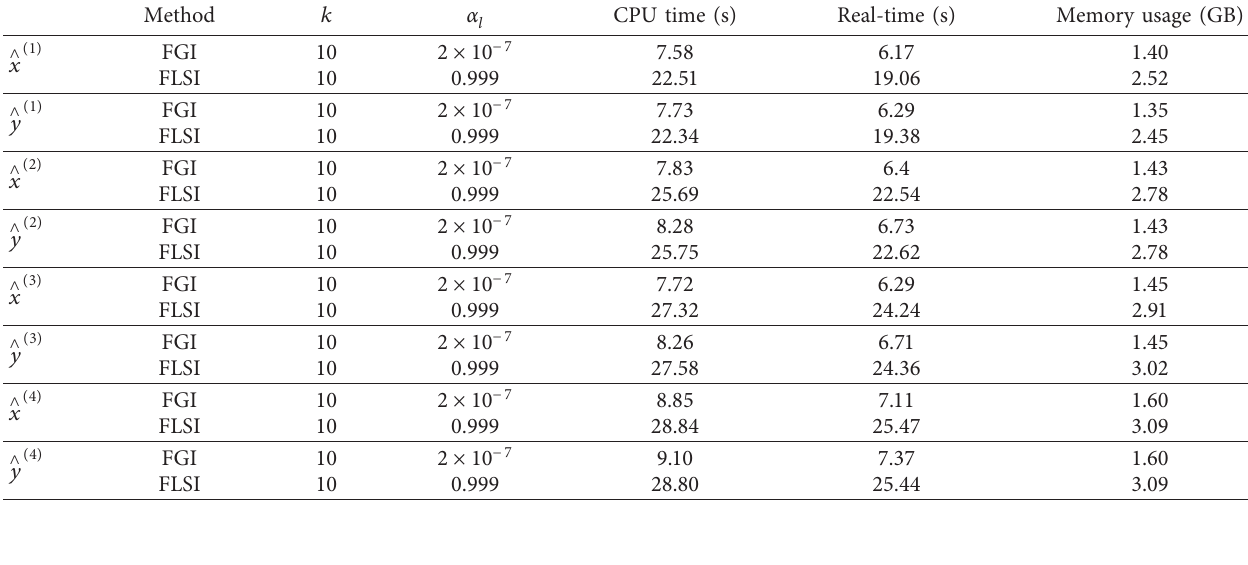
Table 3: Comparison between FGI and FLSI for Example